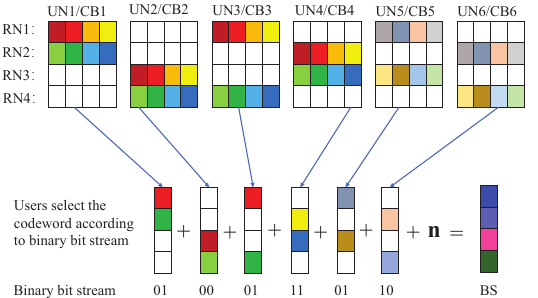
Figure 1. SCMA system model with the parameters J = 6, K = 4, N = 2, and df = 3 for the AWGN uplink